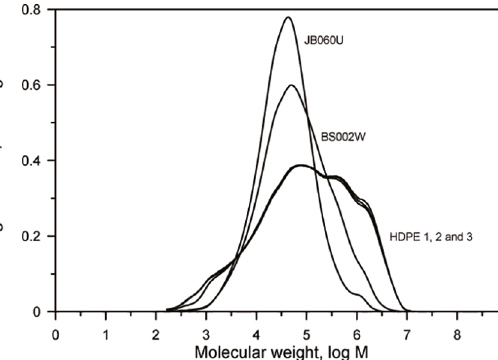
Figure 4. Molecular weight distribution of the commercial and laboratory polymers.